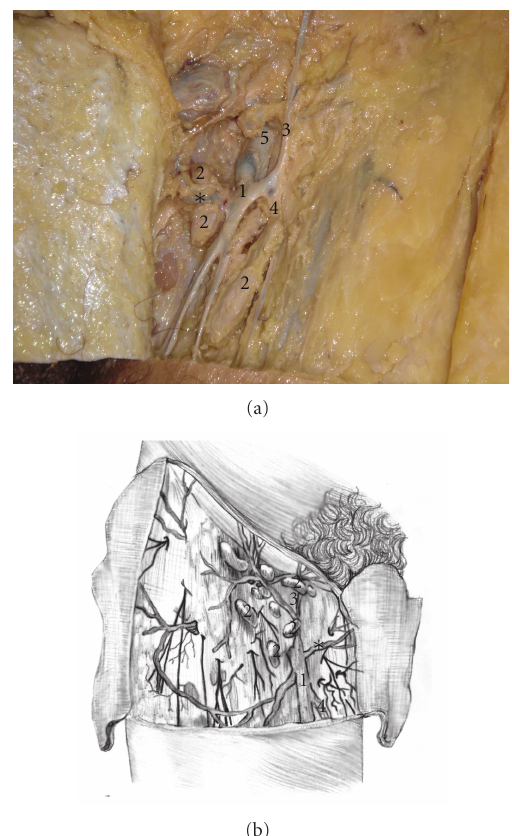
Figure 2: (a) Inguino crural dissection in a formalin-preserved cadaver. The subcutaneous tissue has been removed and the follow- ing structures can be identified: (1) saphena magna vein; (2) super- ficial lymph nodes; (3) superficial epigastric vein; (4) accessory saphena vein; (5) ∗ -external pudendal vein. (b) Schematic draw of the superficial inguinal region and